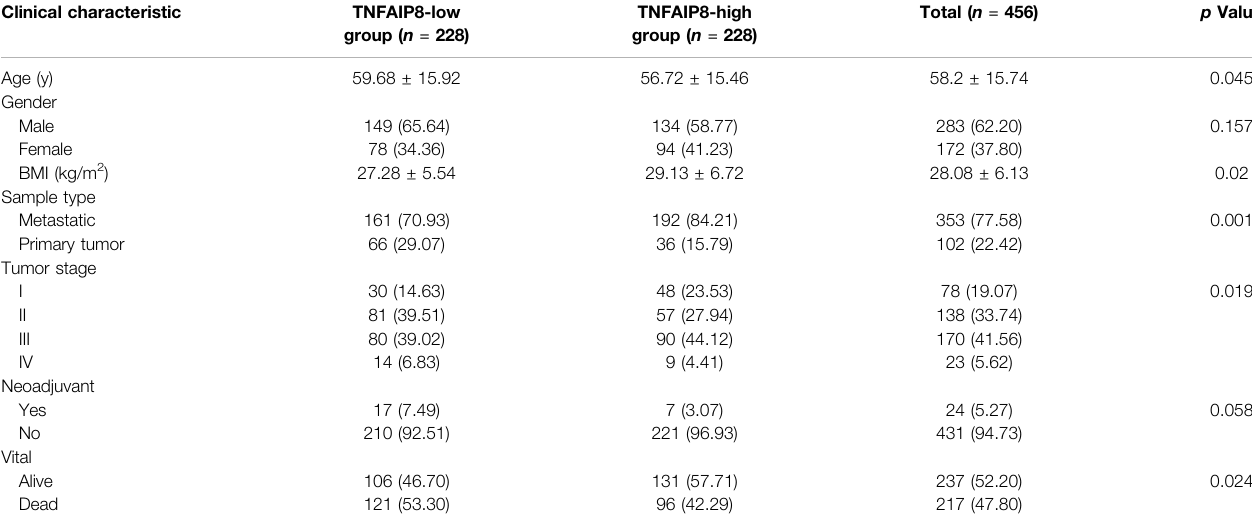
*Data are represented as mean ± SD and frequency (percent) for numeric and category variables, respectively.